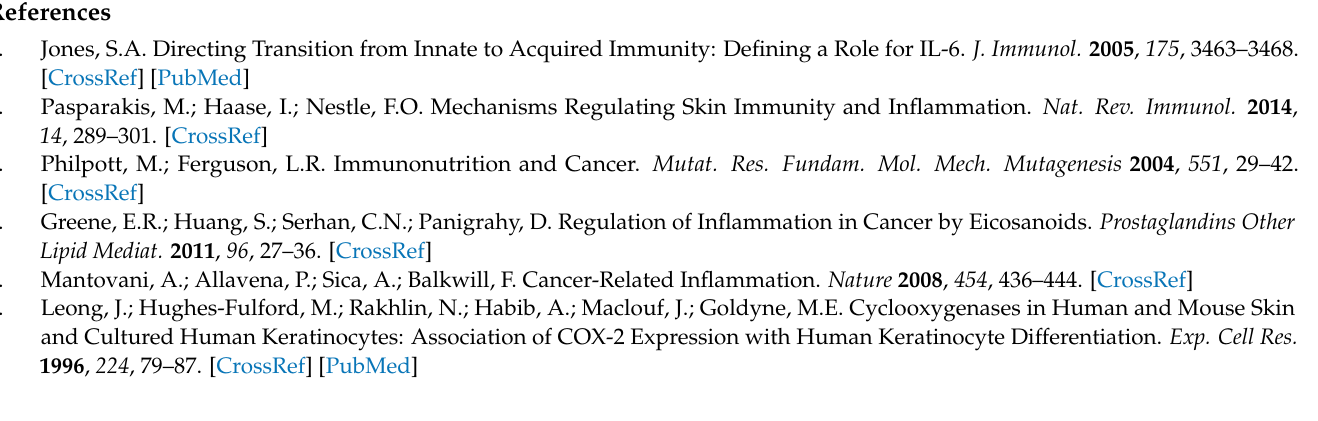
of CPC fraction L-F2 with (A) CAD and (B) DAD at 200 nm. Figure S2: UHPLC chromatogram of CPC fraction L-F3 with (A) CAD and (B) DAD at 200 nm. Figure S3: UHPLC chromatogram of CPC fraction T-F2 with (A) CAD and (B) DAD at 200 nm. Figure S4: UHPLC chromatogram of CPC fraction T-F5 with (A) CAD and (B) DAD at 200 nm. Figure S5: UHPLC chromatogram of CPC fraction T-F6 with (A) CAD and (B) DAD at 200 nm. Figure S6: UHPLC-UV chromatogram at 200 nm of (A) CPC fraction T-F5 (2 mg/mL) and (B) alpha-linolenic acid reference standard (0.05 mg/mL), (C) linoleic acid (0.05 mg/mL), (D) oleic acid (0.05 mg/mL). Figure S7: MS data of (A) peak at Rt = 33.91 with a single charge state of MH-277.2 g/mol and (B) alpha-linolenic acid reference standard. Figure S8: Fragments (A) of 277.2 g/mol signal in fraction T-F5 and (B) of alpha-linolenic acid reference standard. Figure S9: MS data of (A) peak at Rt = 36.00 with a single charge state of MH-279.23 g/mol and (B) linoleic acid reference standard. Figure S10: Fragments (A) of 279.2 g/mol signal in fraction T-F5 and (B) of linoleic acid reference standard. Figure S11: MS data of (A) peak at Rt = 38.51 with a single charge state of MH-281.2 g/mol and (B) oleic acid reference standard. Figure S12: Fragments (A) of 281.2 g/mol signal in fraction T-F5 and (B) of oleic acid reference standard. Figure S13: IC 50 values ( µ g/mL) of extracts (left of dashed line) and CPC fractions (right of dashed line) required to inhibit 0.1 mM DPPH. Table S1: Phytochemical composition in mg/g dry sample and relative COX-2 inhibition to control (%) of the Waltheria Indica leaf